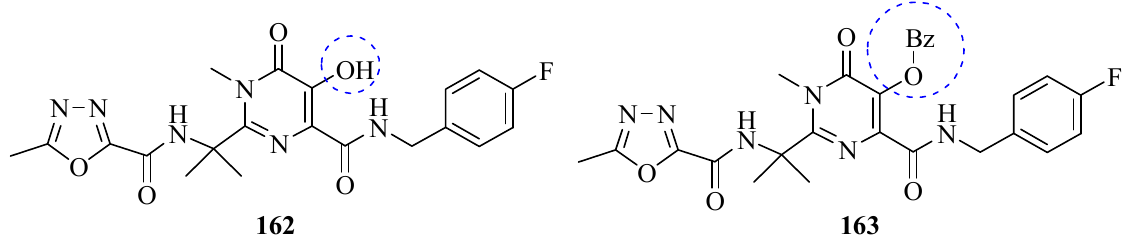
Figure 11. Structures of raltegravir ( 162 ) and